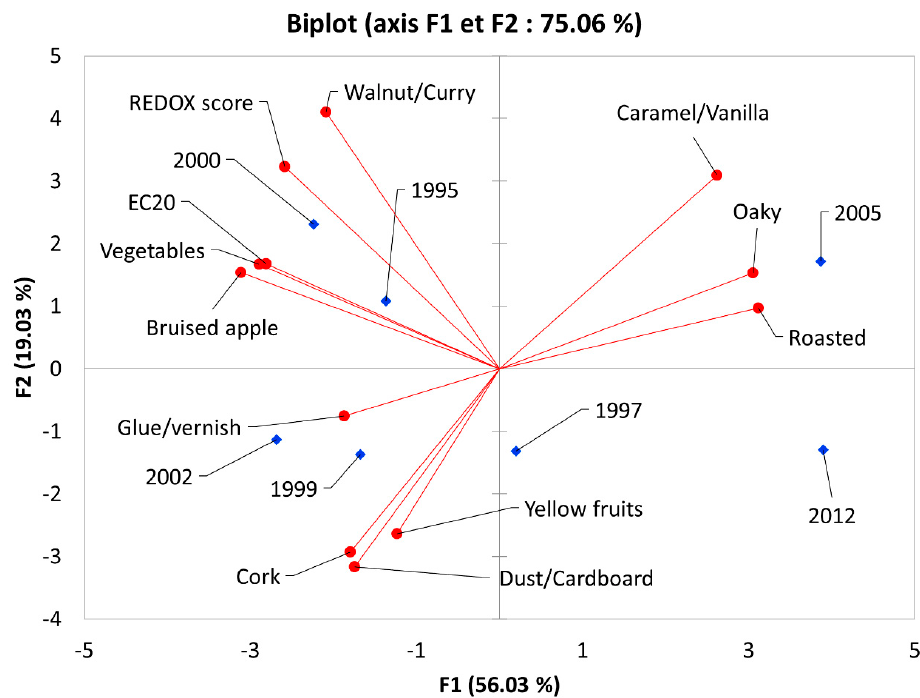
Figure 5. Principal component analysis (PCA) biplot representing the oxidation levels determined by sensory analyses and revisited DPPH measurements.